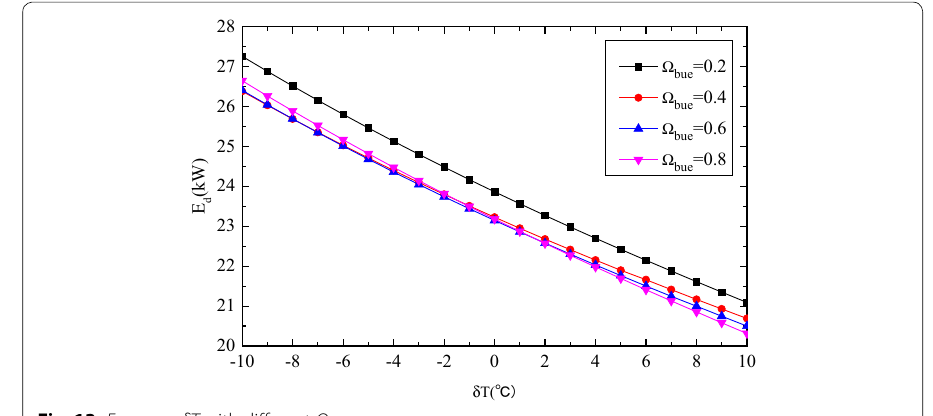
Fig. 13 E d versus δT with different Ω